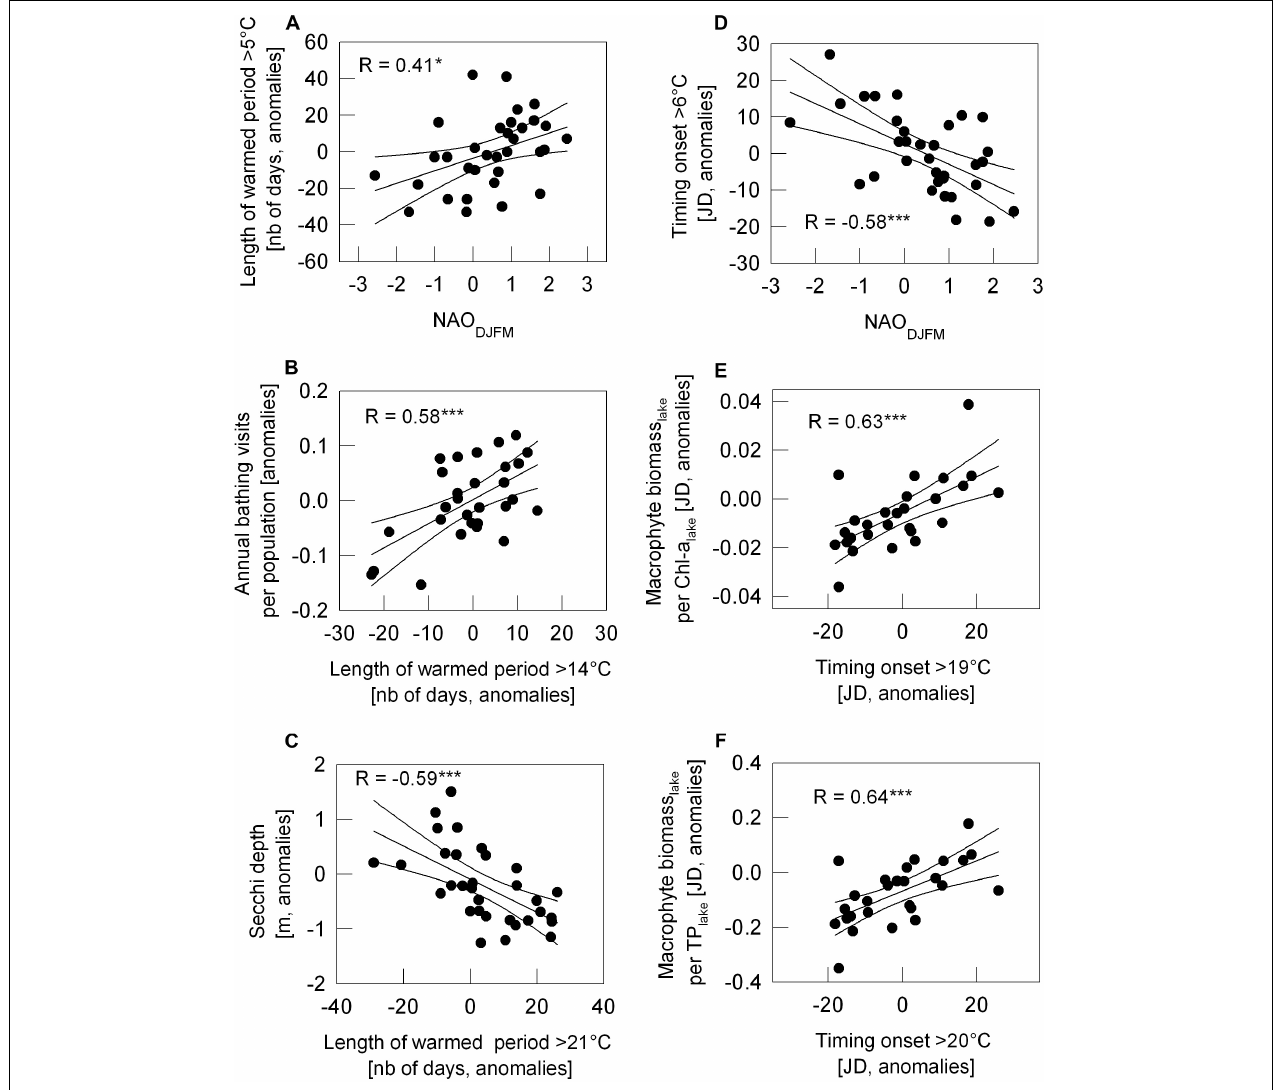
FIGURE 7 | Relation between year-to-year variation of the length of warm period number of days, (A–C) or of the onset of warming period (JD, Julian day; D–F ) and year-to-year variation of NAO climate signal or further parameters indicating ecosystem status as scatter plots. NAO DJFM against the length of warmed period above 5 ◦ C in panel (A) and the onset > 6 ◦ C in panel (D) . Length period > 14 ◦ C against annual bathing visits per population in Vienna (B) ; Length of period > 21 ◦ C against mean Secchi depth during bathing season June–August (C) ; First day a year with WT > 19 ◦ C against the ratio of macrophyte biomass (per lake) to Chl- a (per lake) (E) ; First day a year with WT > 20 ◦ C against the ratio of macrophyte biomass (per lake) to TP (F) . With exception of NAO, all data as anomalies (see section “Materials and Methods”). R for Pearson correlation coefficient, significance of correlation is marked by * p < 0.05 and *** p <